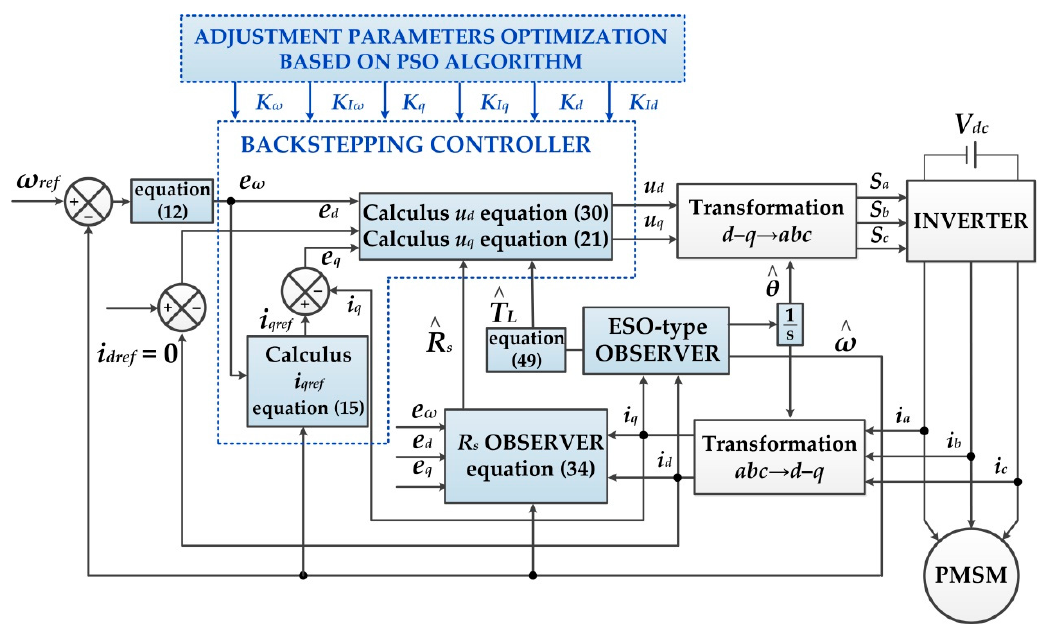
Figure 5. The proposed PMSM control system based on the backstepping-PSO controller.